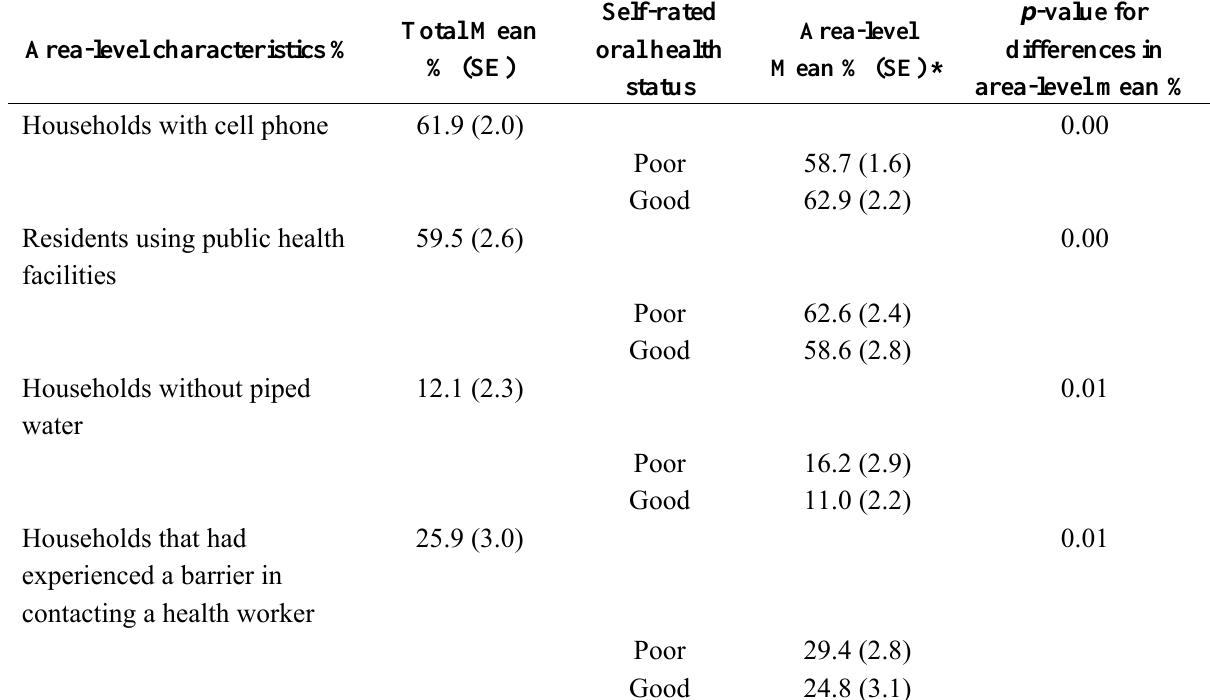
Table 2. Descriptive characteristics of community-level variables by self-rated good oral